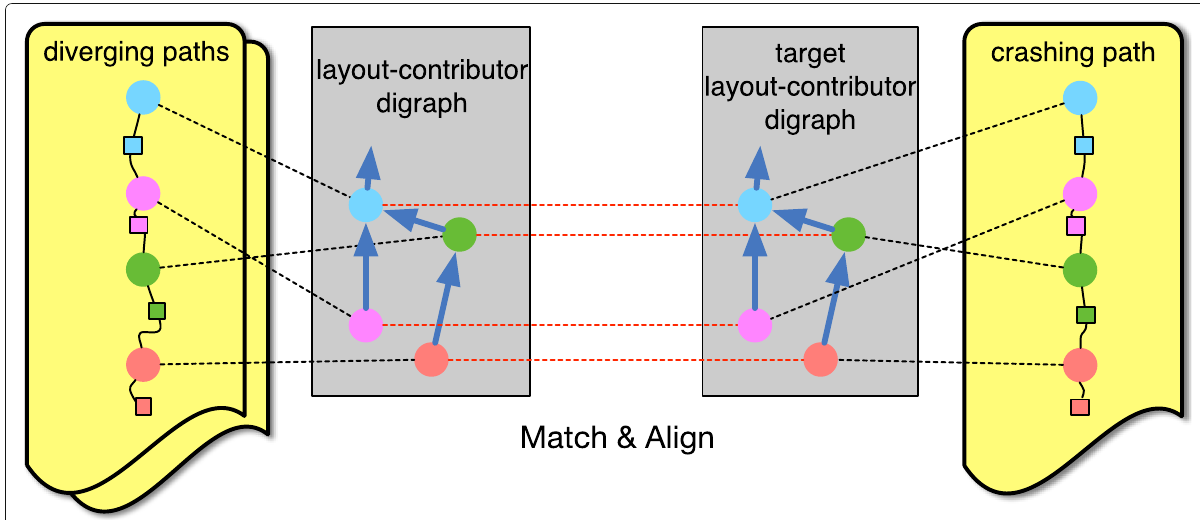
Fig. 7 Filter diverging paths by matching their layouts against target crashing path’s and aligning them when